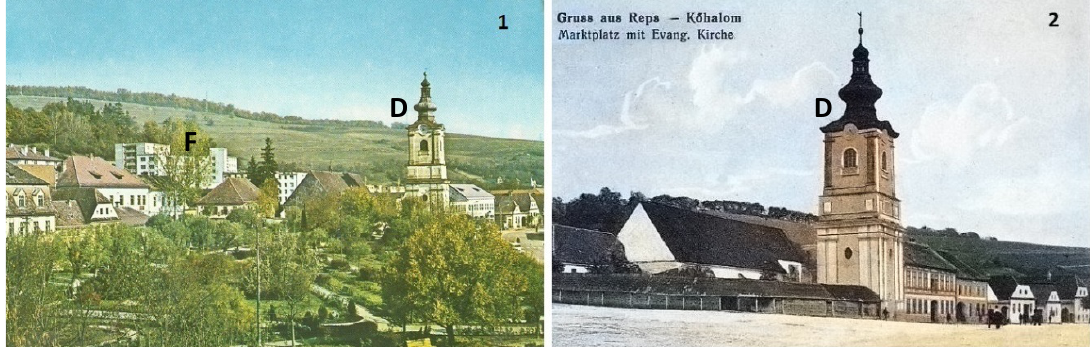
Figure 8: Postcards with view on the Saxon’s Tower Rupea-Reps in different epochs 1 – Systematization in the communist time and the Central Park cca. 1970, 2 – cca.